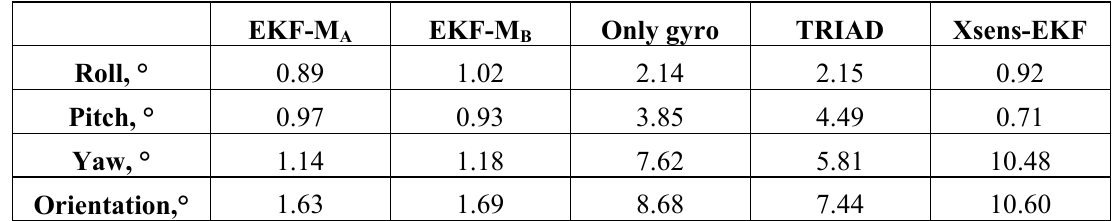
Table 4. RMSE statistics—EKF vs. competing filter implementations.